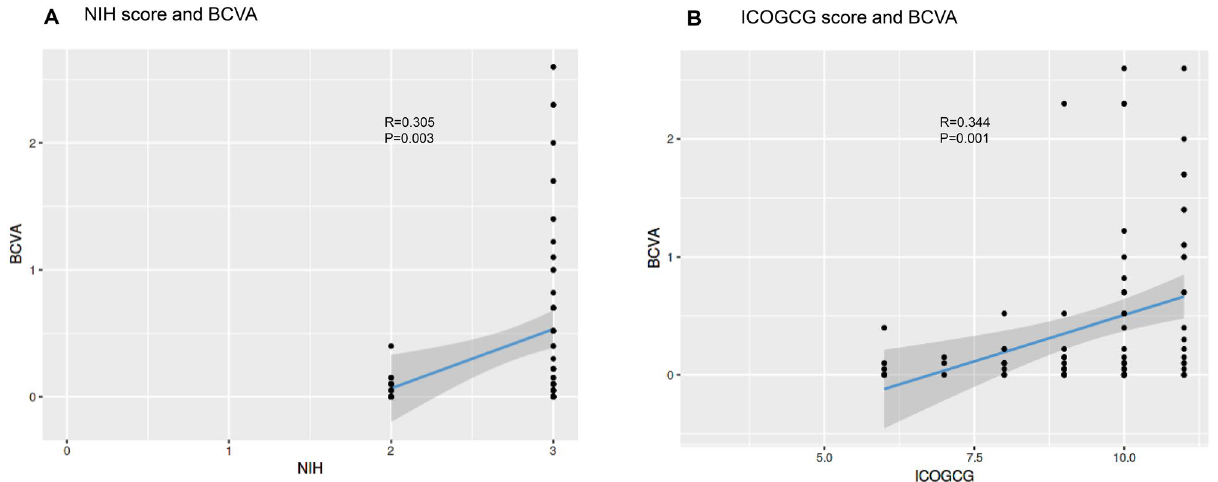
Figure 1. Correlation between final best-corrected visual acuity (BCVA), National Institute of Health (NIH) ocular scores, and International Chronic Ocular Graft-versus-Host-Disease (GVHD) Consensus Group (ICOGCG) score.